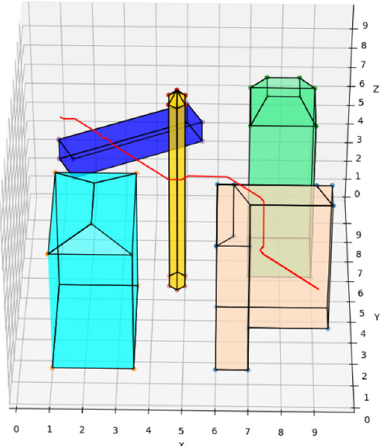
Figure 10. UAV route deploying REPARE algorithm in disturbance-free scenarios.